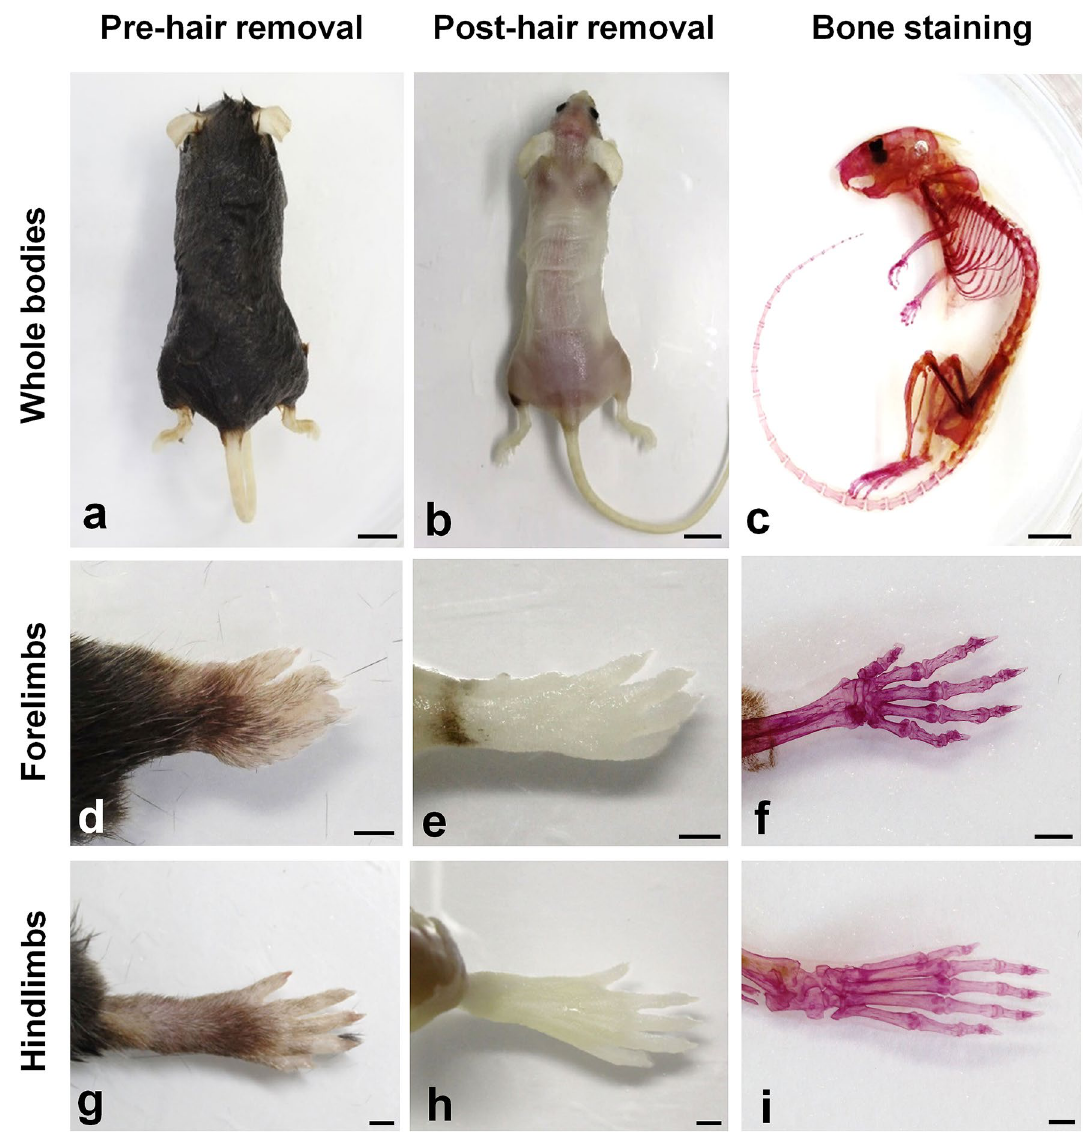
Figure 3. Adult mouse whole-mount bone staining using a modified RAP-B modified with hair removal (RAP-B/HR). Before whole-mount bone staining, RAP-B, specimens were incubated in a mixture of 2% sodium mercaptoacetate and 3% KOH for hair removal. However, the soft tissues, including the skin and muscles, were left behind ( a , d , and g vs. b , e , and h , respectively). Subsequently, specimens were stained using the RAP-B procedure and cleared with BABB, then dehydrated with methanol ( c , f , and i ). Scale bars in a – c : 1 cm; in d – i : 2